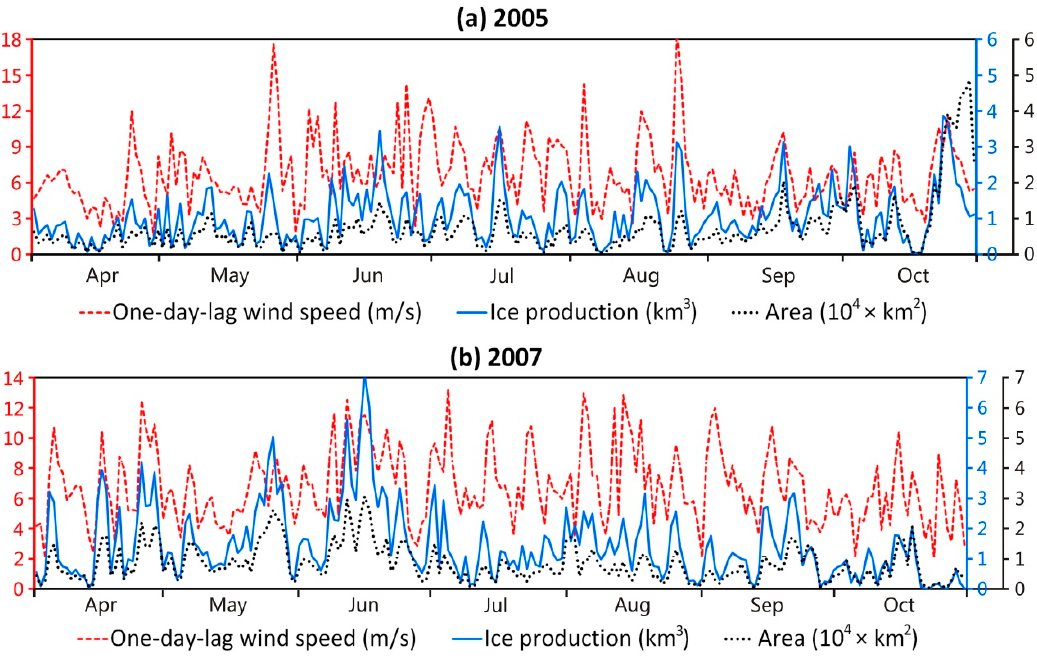
Figure 6. Time series of daily wind speed with one day lag, ice production and polynya area in 2005 ( a ) and 2007 ( b ).